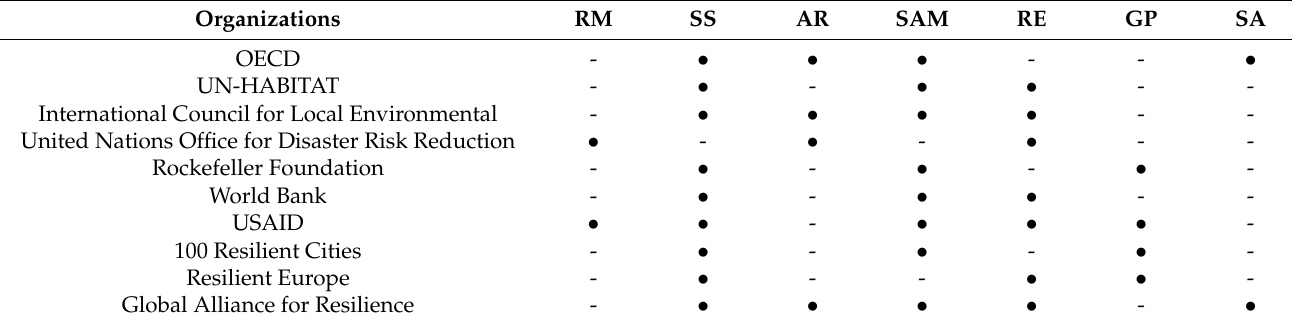
Table 1. The keywords of “urban resilience”